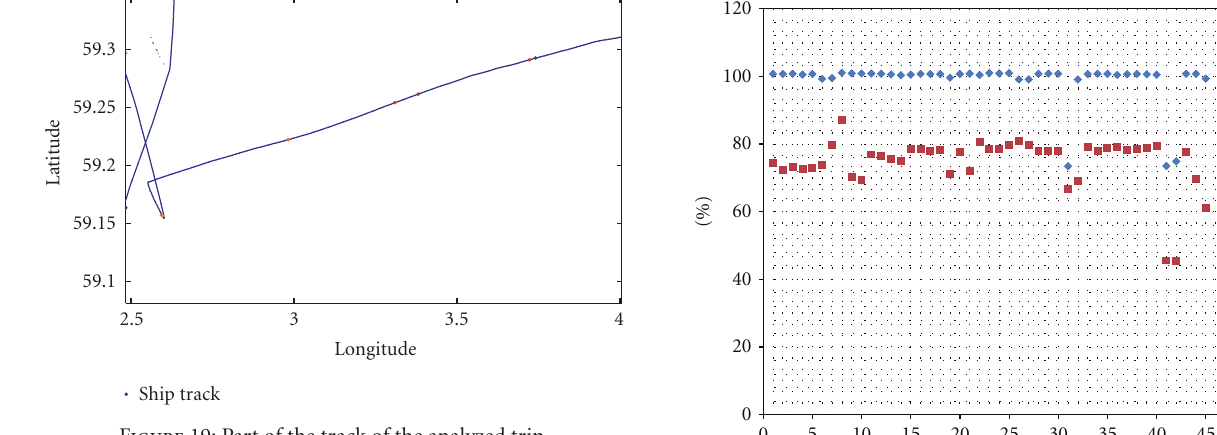
Figure 19: Part of the track of the analyzed trip.